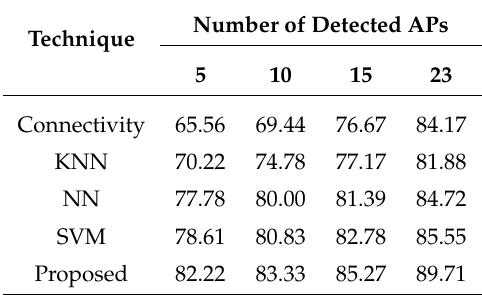
Table 5. Comparison between different methods in terms of overall accuracy (%), as a function of the number of